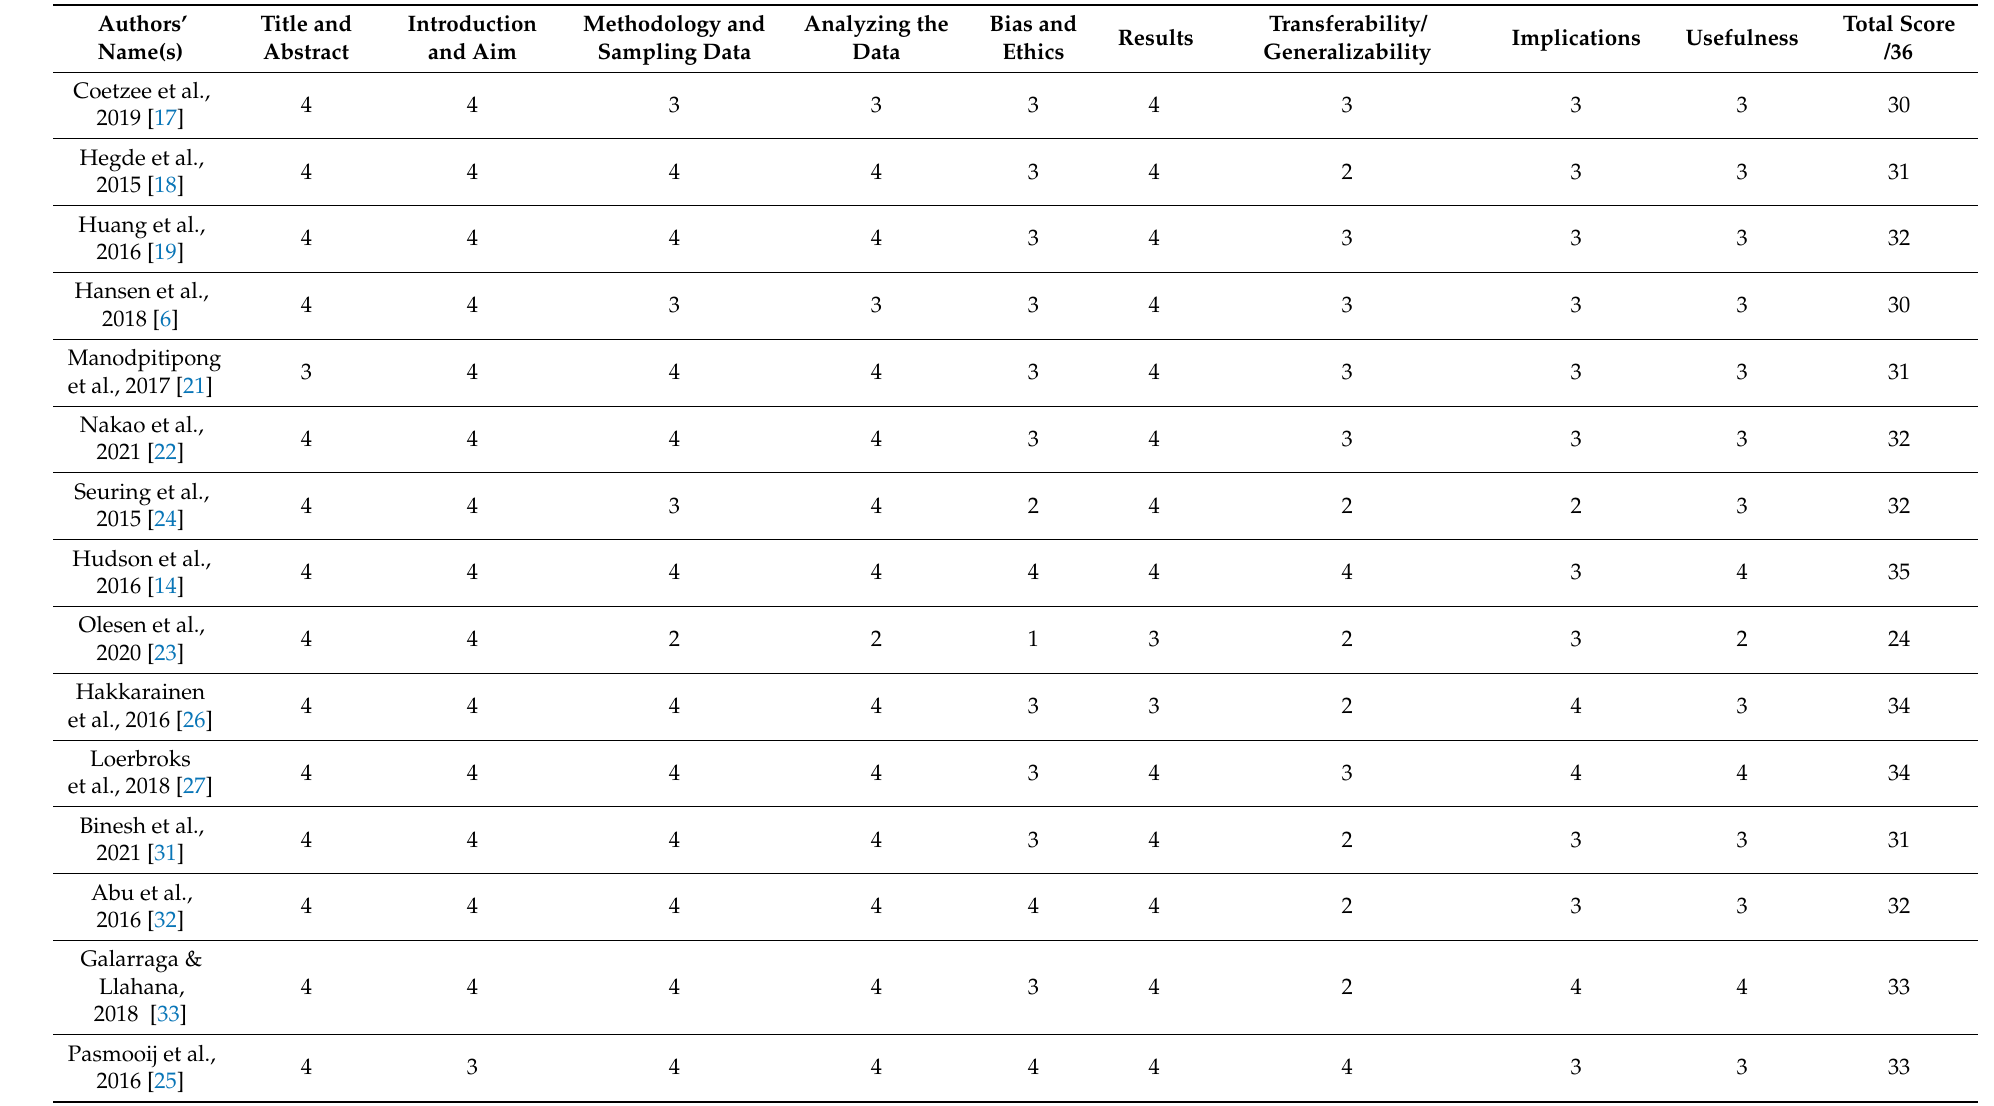
Table A2. Quality Assessment of Included